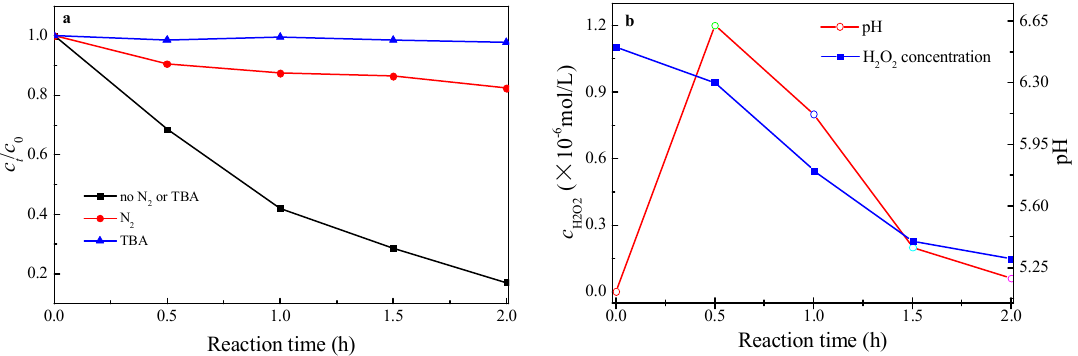
Figure 5. ( a ) Degradation of CYN under different conditions; ( b ) pH and H 2 O 2 evolution in the degradation solution. CYN concentration = 2 mg/L; tert-butyl alcohol (TBA) concentration = 2 μ L/mL; pyrite dose = 0.5 g/L.